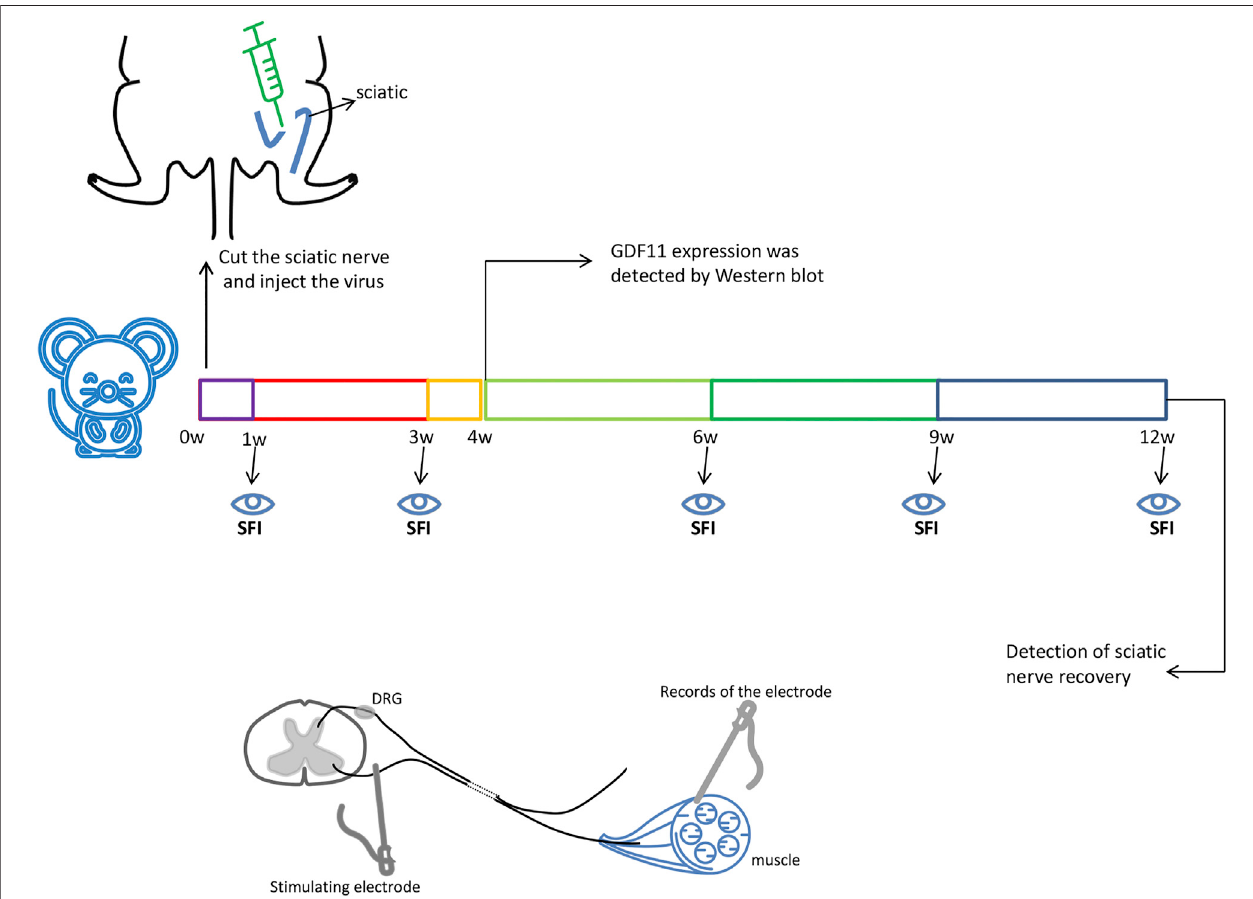
FIGURE 1 | The sciatic nerve of rats was surgically cut off 8mm, and then injected with GDF11 lentivirus or control virus immediately. The sciatic nerve of rats was taken 4 weeks after surgery to detect the expression of GDF11, and SFI values were measured at 1, 3, 6, 9, and 12 weeks, respectively. The sciatic nerve recovery was measured at 12 weeks. Stimulating electrodes were used at the proximal end of the injury, and evoked potentials were detected at the distal muscle.